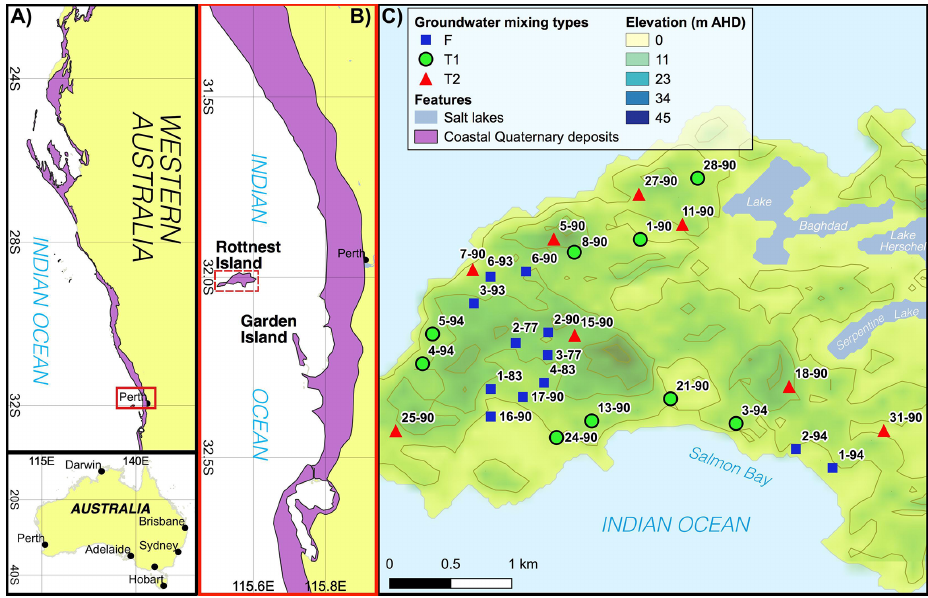
Figure 1. (a,b) Maps showing the locations of coastal Quaternary deposits in Western Australia (Stewart et al., 2008). (c) A digital elevation model of RI, Australia, showing sampling locations and IDs (modified from Martin et al., 2020). Groundwater classification types are defined according to Bryan et al. (2017), and underlined sample IDs represent bores with available groundwater residence times modelled by Bryan et al. (2020). The red dashed line in C shows the location of the cross section shown in Fig.